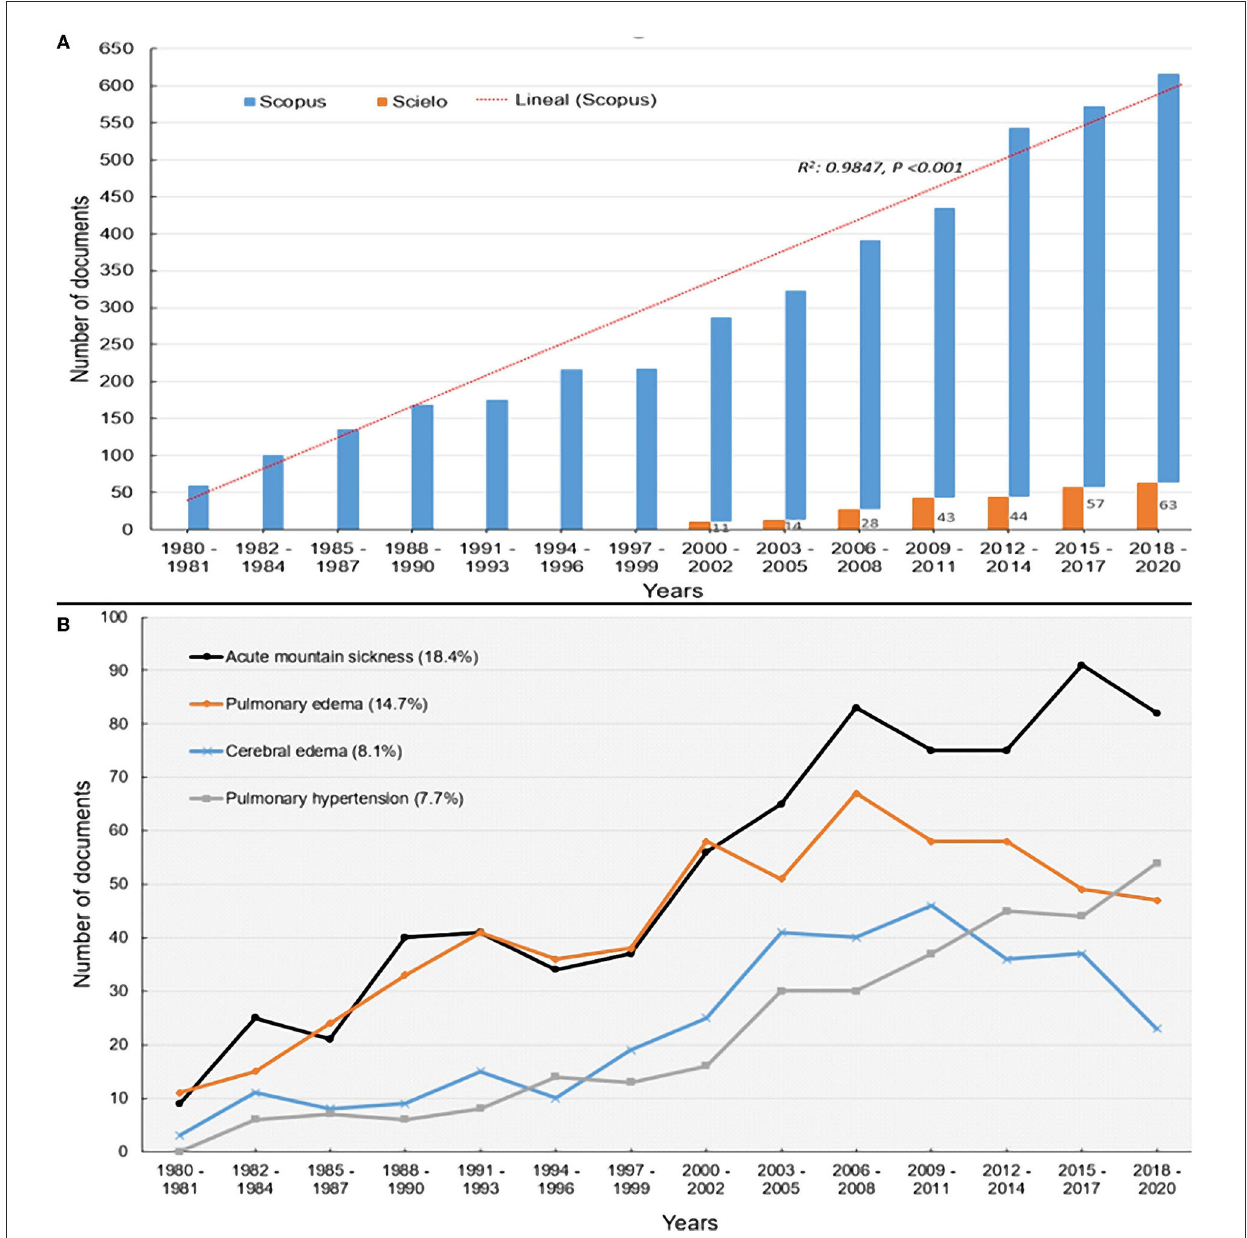
such as the United States and United Kingdom, were presented with more than 7 publications and the journal “Journal of Applied Physiology” was the one that obtained the highest number of citations (Table 3 in Supplementary material 2). No Latin American, Asian, or African journals were